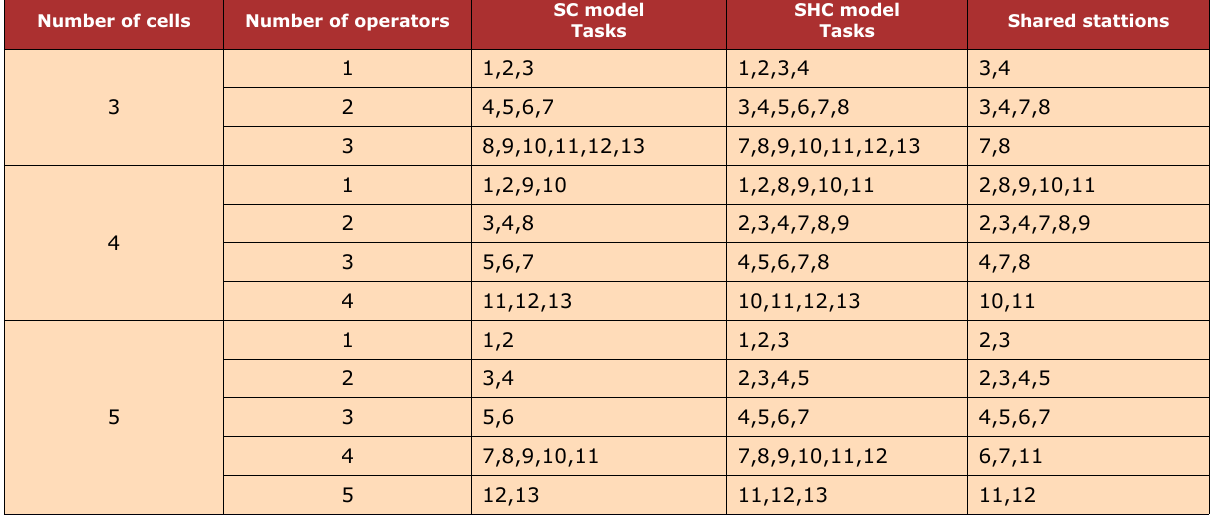
Table 2. Sub-unit divisions under SC and SHC